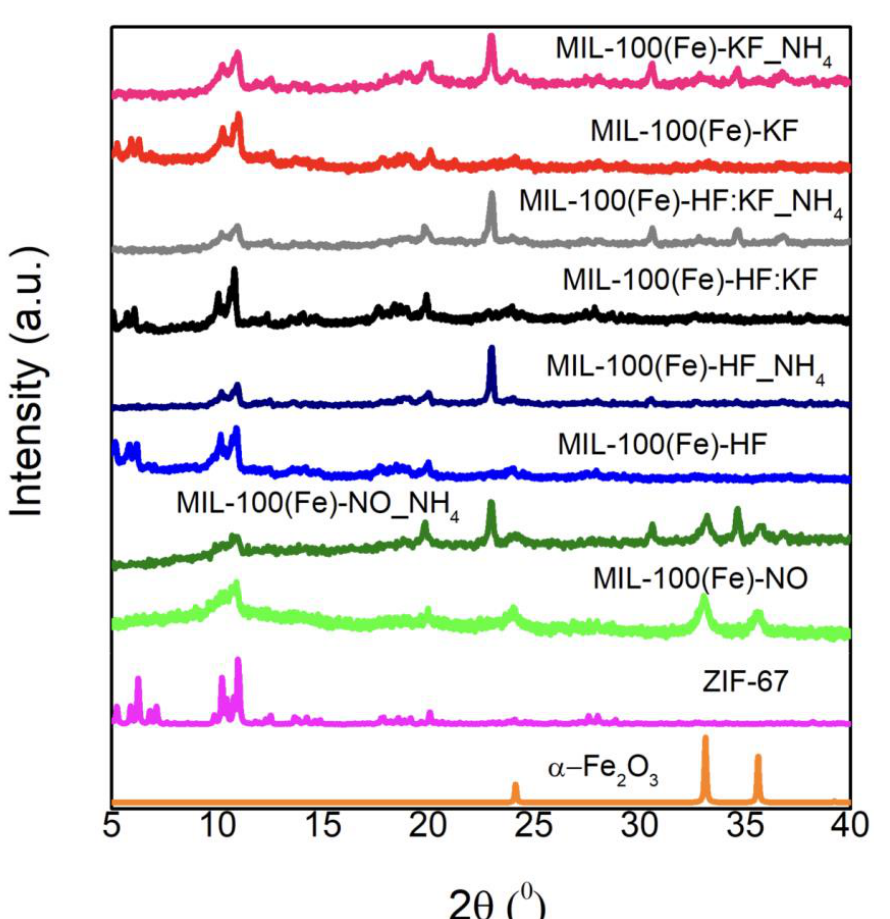
Figure A4. Comparison of the XRD patterns of the samples treated and untreated with NH 4 F .